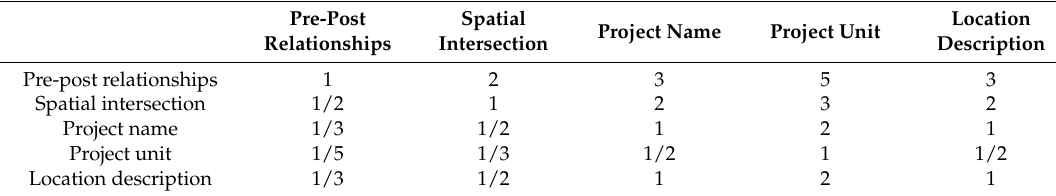
Table 4. Judgment matrix for the scoring factors of the criterion layer.